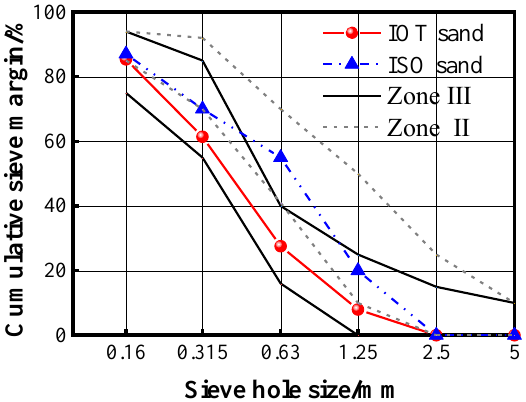
Figure 5. Sieve margin curve of IOT sand and ISO sand.